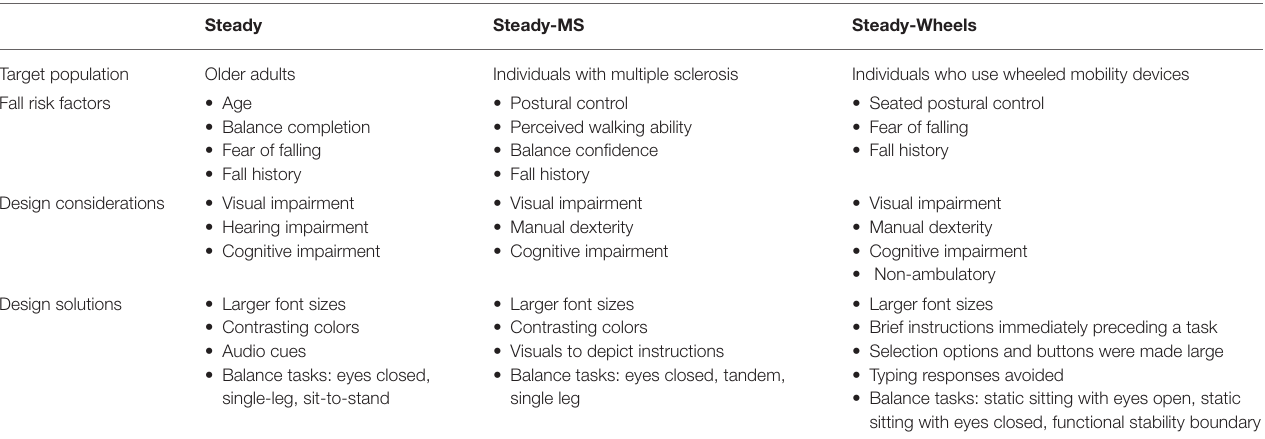
TABLE 1 | Similarities and differences between Steady, Steady-MS, and Steady-Wheels.